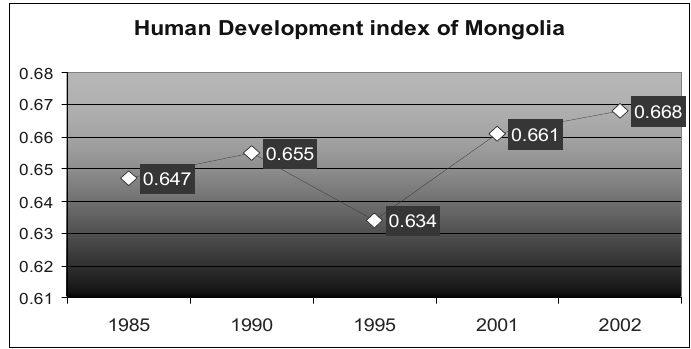
Fig. 4 – Human development index -